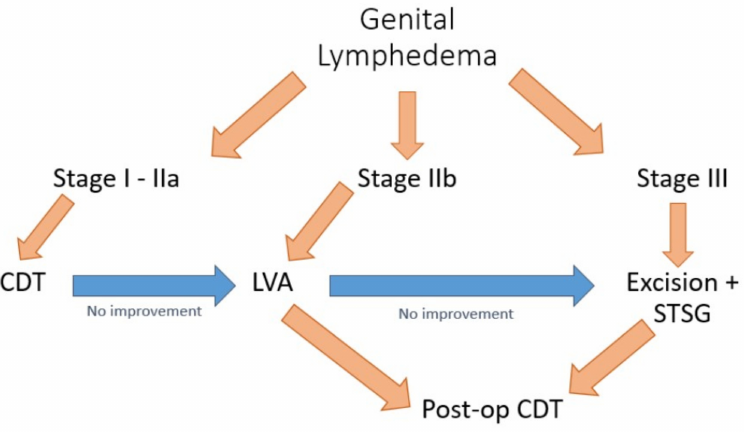
Figure 1. Treatment algorithm applied to manage